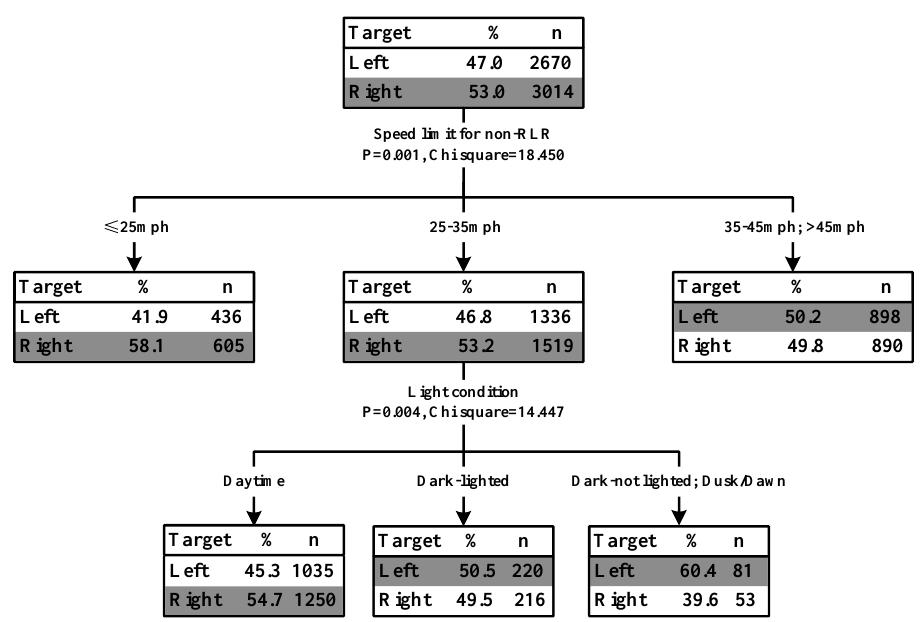
Figure 3. Tree model for RLR crash types #1 go-straight (GS) RLR and GS non-RLR.